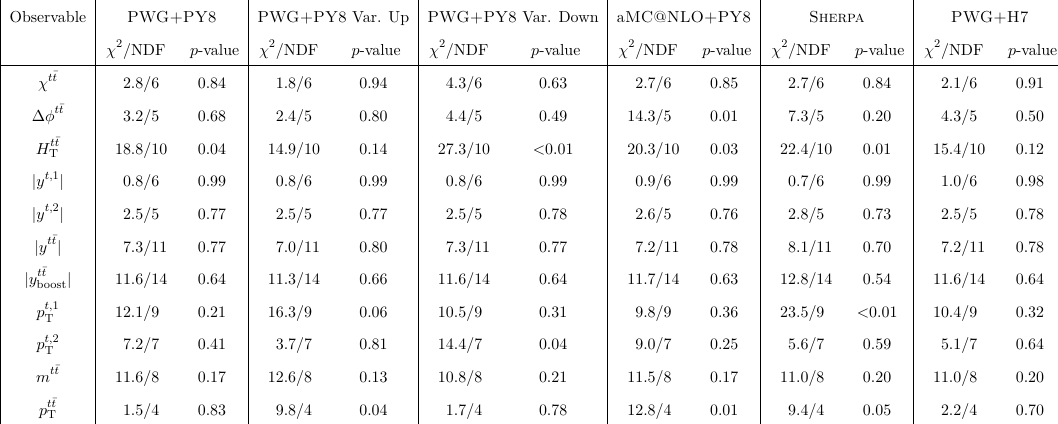
Table 13 . Comparison of the measured parton-level normalised single-differential cross-sections with the predictions from several MC generators. For each prediction, a χ 2 and a p -value are calculated using the covariance matrix of the measured spectrum. The number of degrees of freedom (NDF) is equal to the number of bins in the distribution minus